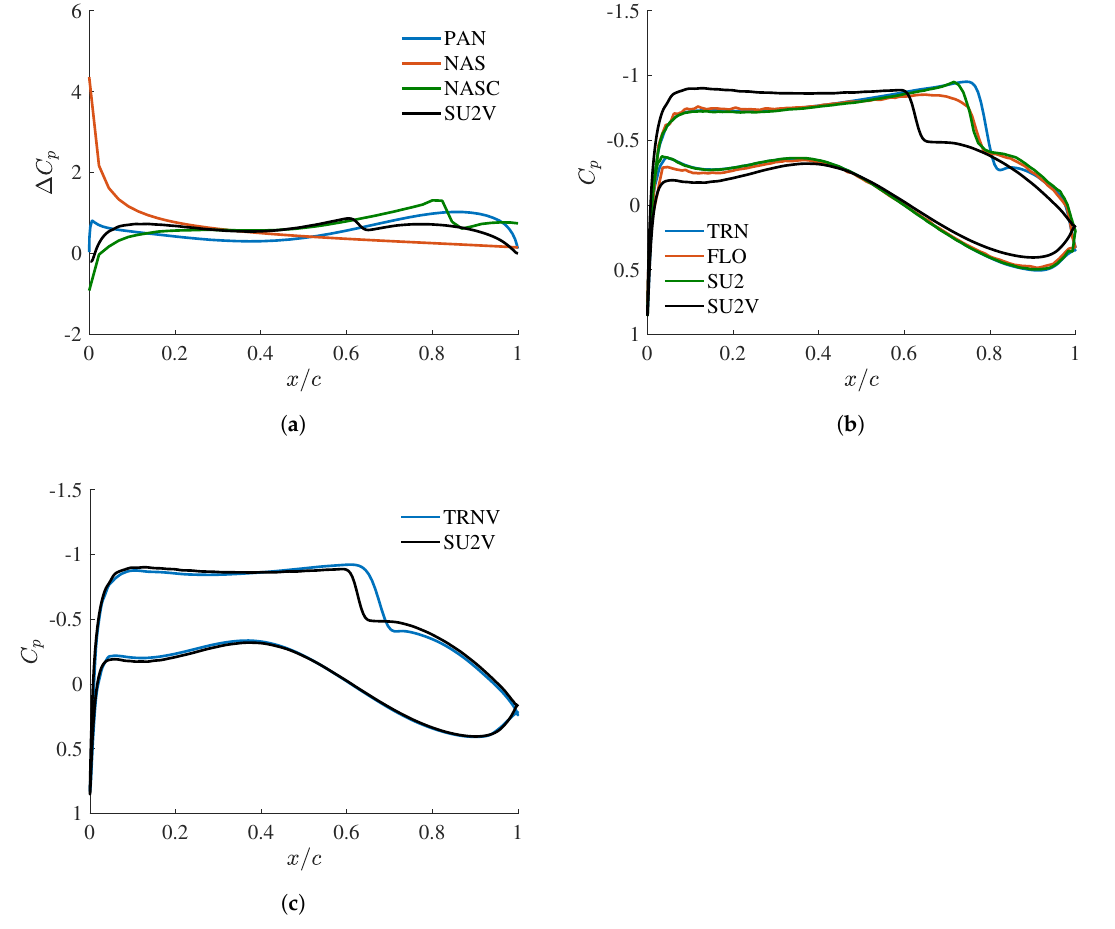
Figure 5. Pressure distribution along the mean aerodynamic chord of the Embraer Benchmark Wing at Mach 0.78 and lift coefficient 0.60 obtained from different varying levels of fidelity: ( a ) linear models; ( b ) nonlinear inviscid models; and ( c ) viscous